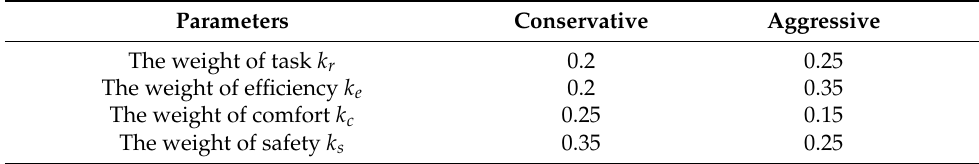
Table 2. Weight coefficient of the decision-weighted coefficient matrix.